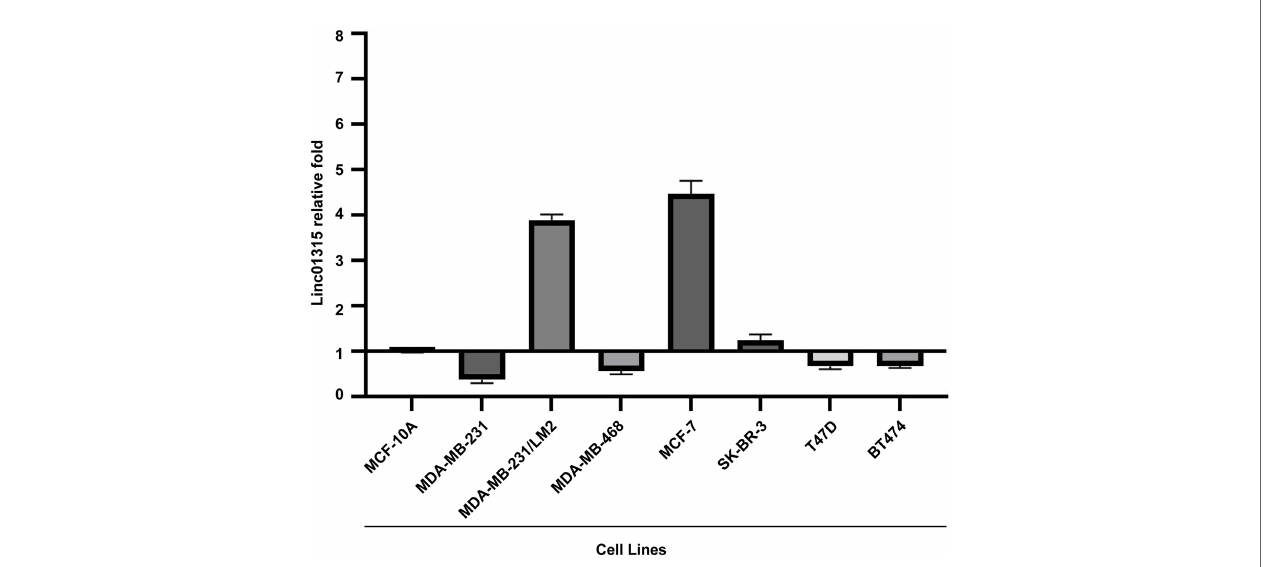
FIGURE 1 | Linc01315 expression levels in 6 breast cell lines. Compared with normal breast cell line MCF-10A. Linc01315 expression was up-regulated in MDA- MB-231/LM2, MCF-7 and SK-BR-3, down-regulated in T47D and